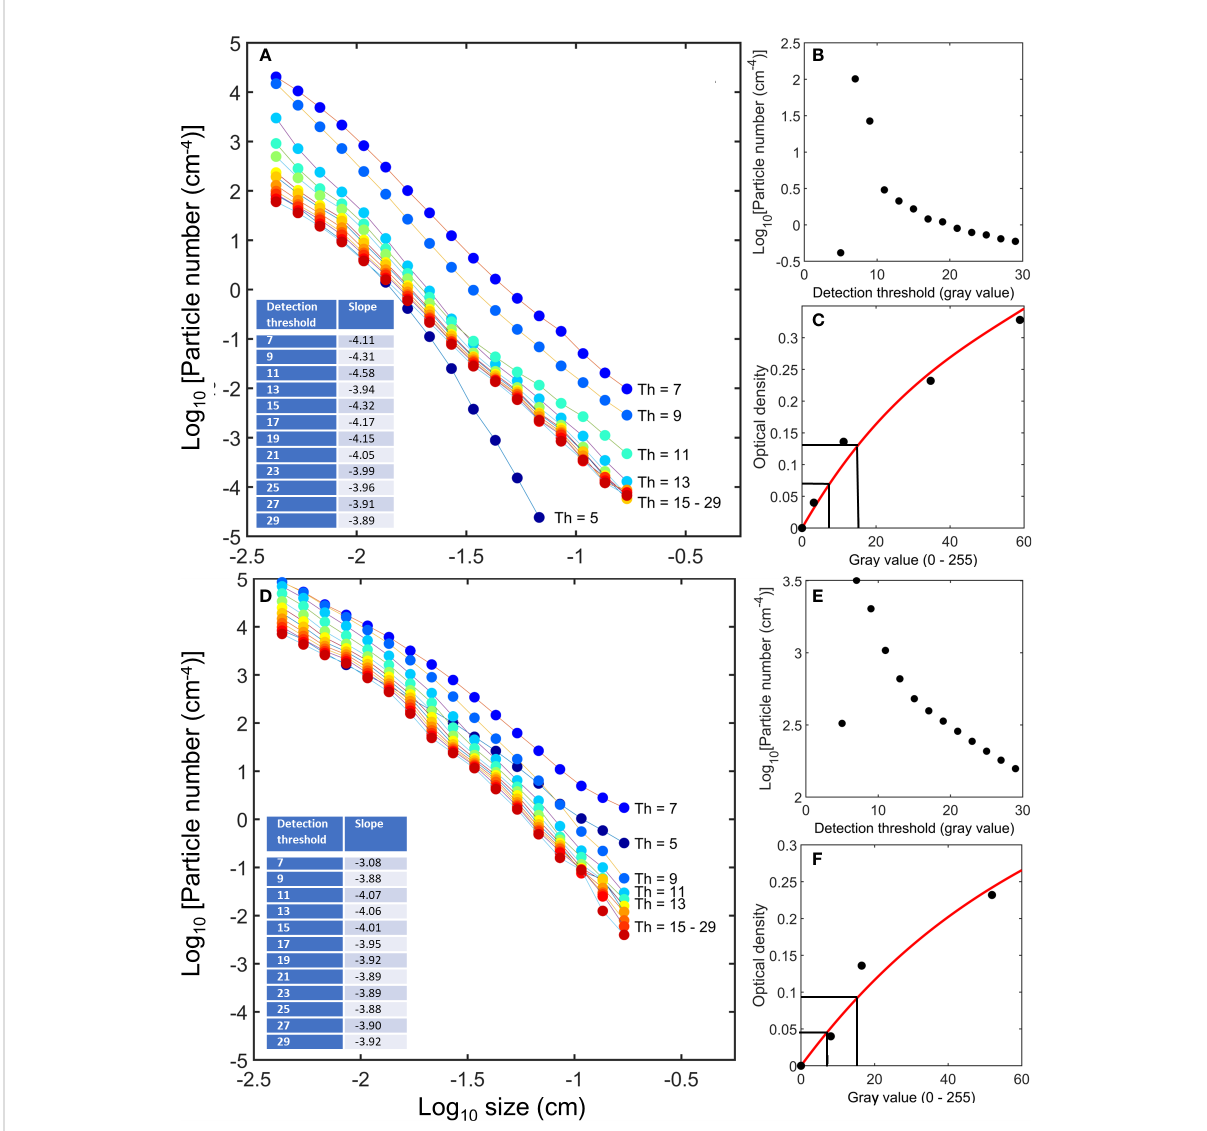
FIGURE 1 Particle number spectra of particles in the size range of 43 m m to 1.7 mm in the Sargasso Sea (A) and the Gulf of Trieste (D) . Warmer colors (red to yellow) represent particle numbers at thresholds typically used in imaging systems. Blue colors indicate lower thresholds at which gels with associated microbial communities and faint detritus become visible. Applying lower detection thresholds, yielded vastly different particle numbers. Particle numbers increased continuously without shoulder or cutoff with decreasing thresholds except for a sudden drop due to image “ whiteout ” at threshold = 5 (particle size bin = 170 m m only, (B, E) . This analysis demonstrates that faint particles (blue shades) outnumber particles that are typically detected (warm colors) by orders of magnitude. Using neutral density fi lters, threshold values can be translated into absolute attenuation values regardless of the instrument in use (C, F) . Black lines in C and F correspond to thresholds 7 and